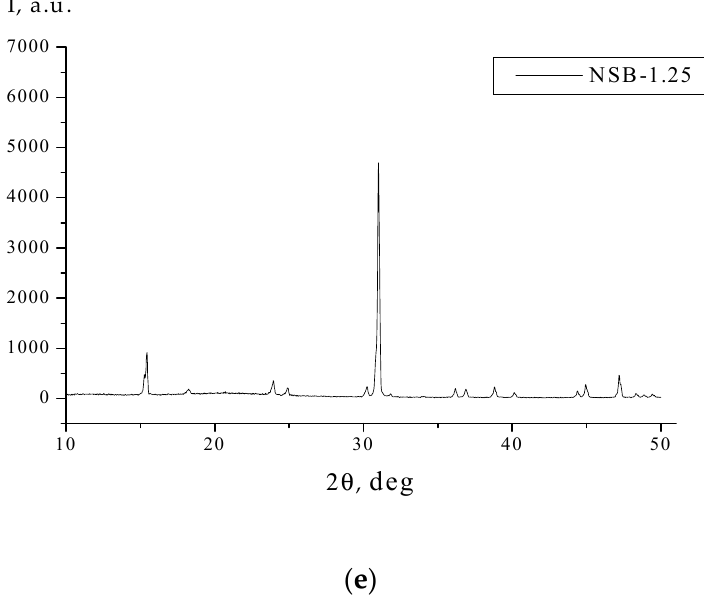
Figure 12. Theoretical diffraction patterns for the ( a ) huntite structure (space group R 32), ( b ) superstructure of the huntite structure (space group P 321), ( c ) structure with the space group P 3 1 21; Experimental diffraction patterns of powdered single crystals (space group P 321): ( c ) Pr 1.1 Sc 2.9 (BO 3 ) 4 (PSB–1.1), ( d ) NdSc 3 (BO 3 ) 4 (NSB–1.0), ( e ) Nd 1.25 Sc 2.75 (BO 3 ) 4 (NSB–1.25).